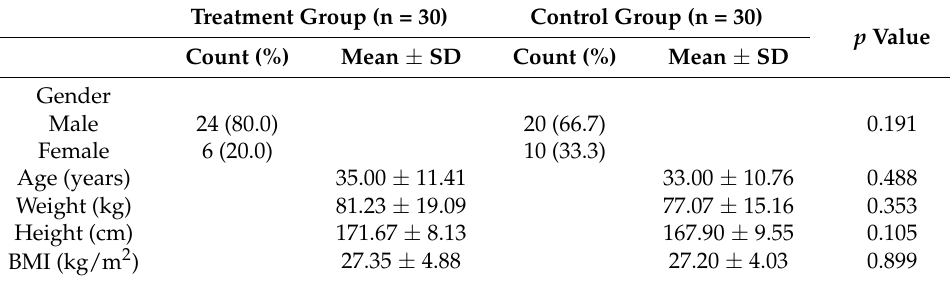
Table 1. Characteristics of the treatment and control